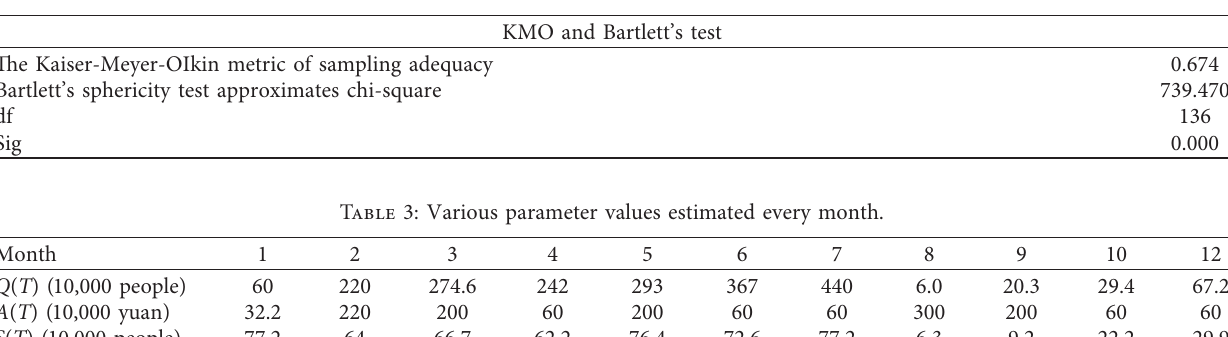
Table 2: KMO and Bartlett’s